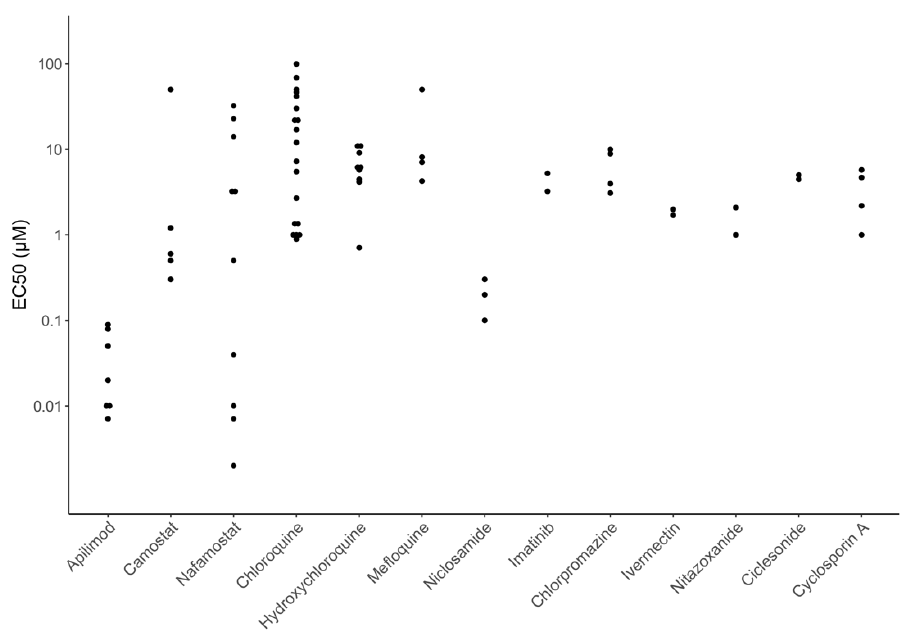
Figure 5. EC 50 values for many of the repurposed host-acting compounds currently in clinical trials including the host protease inhibitors (camostat and nafamostat), six possible endosomal trafficking inhibitors (chloroquine, hydroxychloroquine, mefloquine, niclosamide, imatinib, chlorpromazine) and four inhibitors acting by a variety of different mechanisms (ivermectin, nitazoxanide, ciclesonide, and cyclosporin).